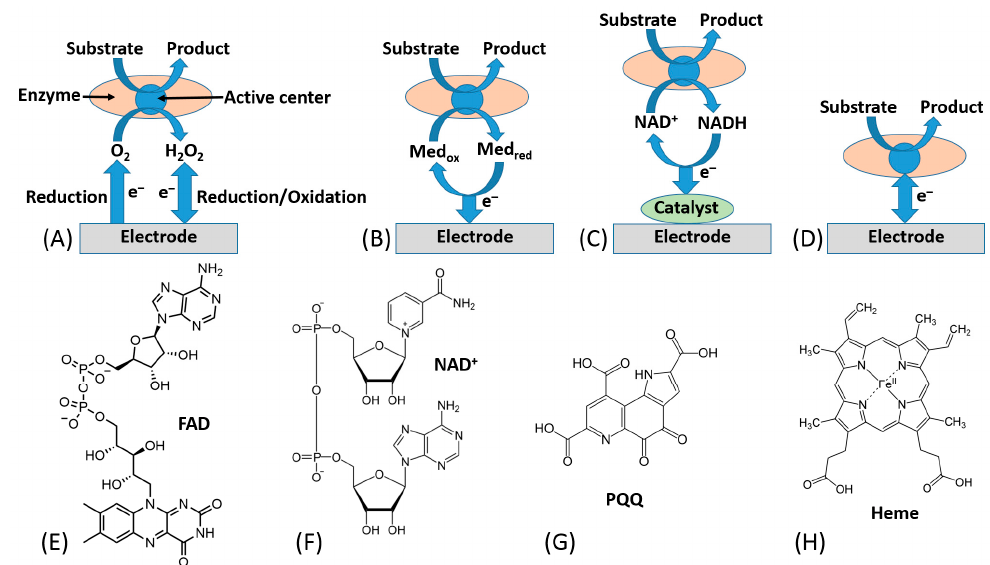
Figure 2. Different ways of electronic communication between redox enzymes and conductive electrodes: ( A ) Electrical communication through electrochemical transformations of enzyme substrate or product (exemplified with reduction of O 2 and reduction / oxidation of H 2 O 2 typical for oxidases). ( B ) Electrical communication using electron transfer mediators (relays) cyclic between oxidized (Med ox ) and reduced (Med red ) states (exemplified with an enzyme oxidizing a substrate and reducing a mediator, which is electrochemically re-oxidized and recycled back to Med ox ). ( C ) Electrical communication using NAD + / NADH cofactor re-oxidized and recycled electrocatalytically (exemplified with an enzyme oxidizing a substrate and reducing NAD + yielding NADH). ( D ) Electrical communication via direct electron transfer (DET) from an enzyme active center to an electrode (exemplified with an enzyme oxidizing a substrate and generating anodic current at an electrode). ( E – H ) Structures of the most typical enzyme redox cofactors: flavin adenine dinucleotide (FAD), nicotinamide adenine dinucleotide (NAD + ), pyrroloquinoline quinone (PQQ) and heme.